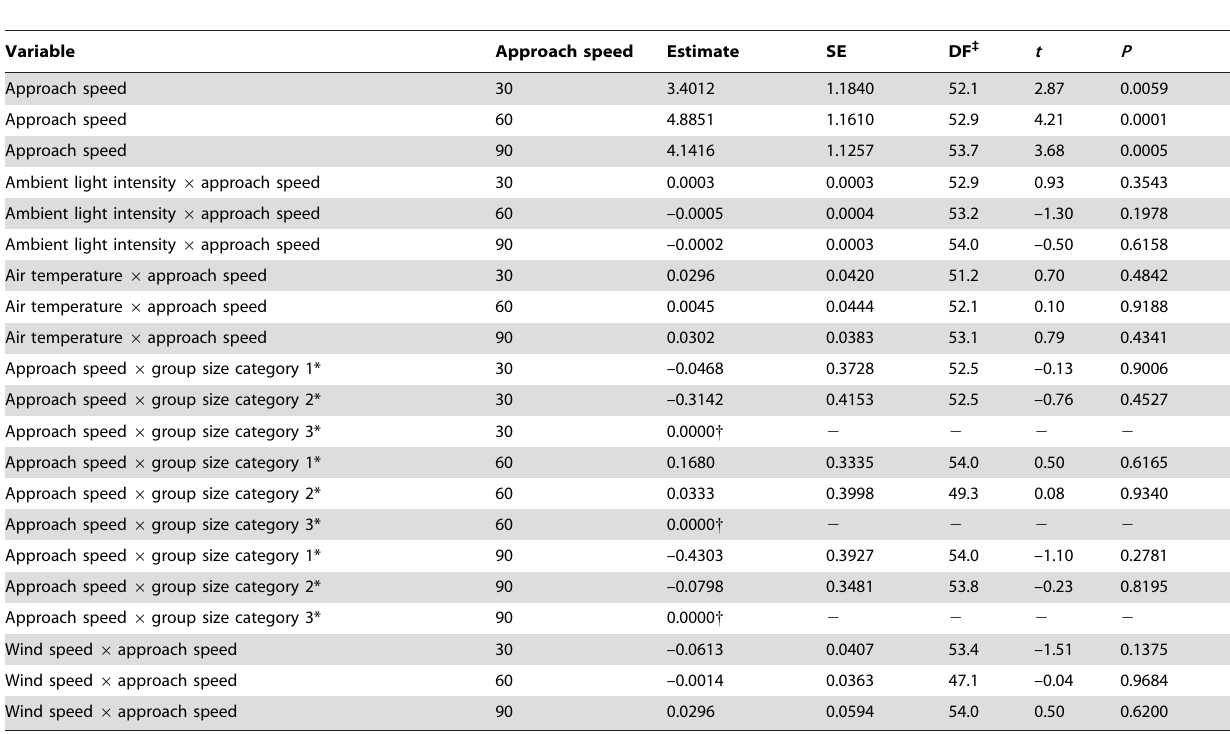
Table 3. Results from a mixed linear model, repeated-measures analysis of flight-initiation distance (FID) for groups of free-ranging turkey vultures exposed to the approach of a Ford F250 pickup truck from a standard 1.13-km distance at 30 kph (n=25 approaches), 60 kph (n=25 approaches, but only 24 considered because of a missing value), or 90 kph (n=23 approaches).